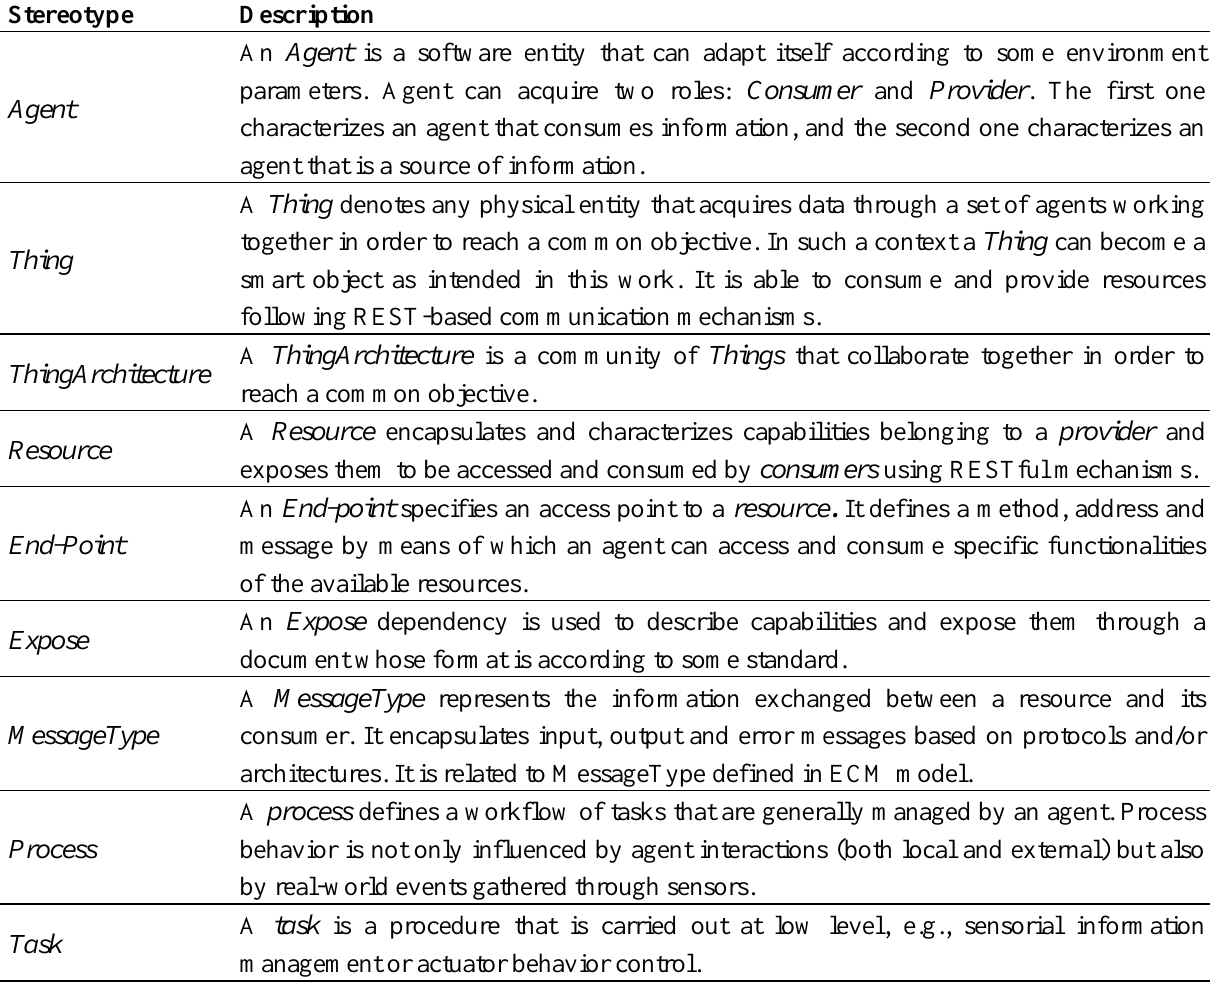
Table 5. Stereotypes of SsML defining concepts to be used in